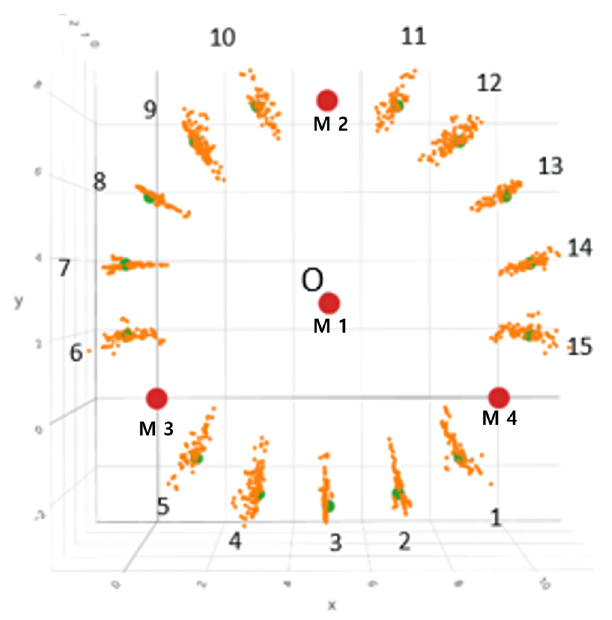
Figure 13. Results of the interior construction site validation test 1.